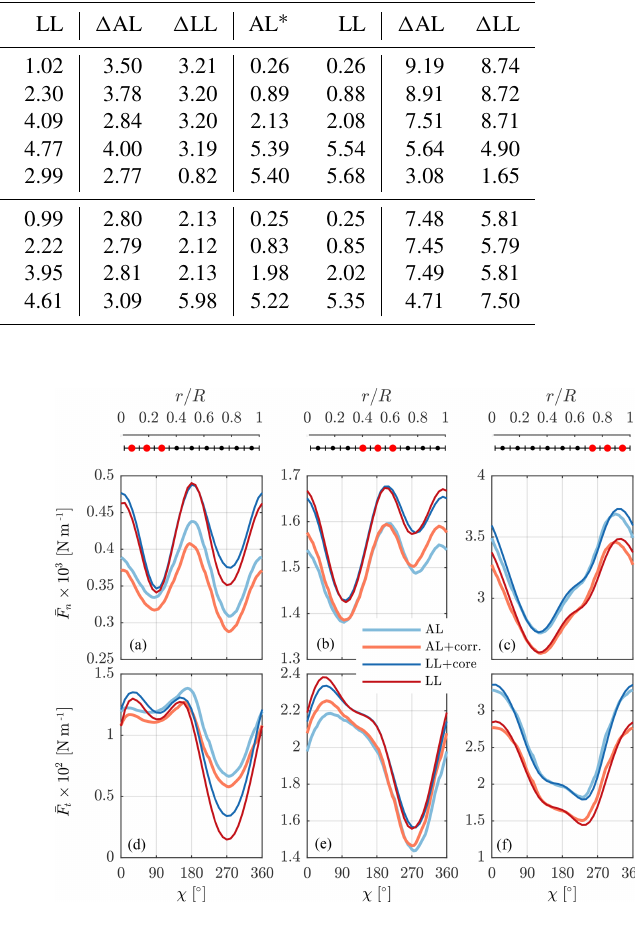
Figure 13. Normal (a, b, c) and tangential (d, e, f) force variation during one rotation as a function of azimuthal position of the NREL 5-MW blades at 8ms − 1 and 45 ◦ yaw. The forces are averaged over three sections (inner: a, d ; middle: b, e ; outer: c, f ) of the blade and are predicted by AL simulations with/without smearing correction and LL with/without viscous core. The blade is facing upwind at χ = 0 ◦ and is pointing vertically up at χ = 90 ◦ ( N s = 9, (cid:15) = 0 . 2 R